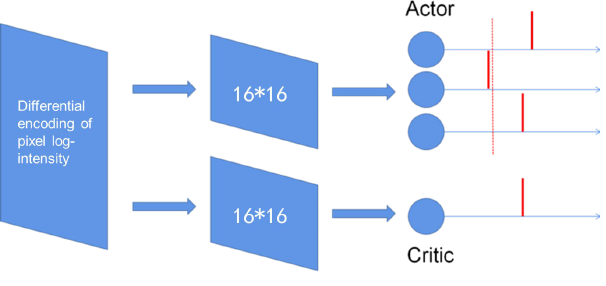
Figure 12. Actor-critic network structure.